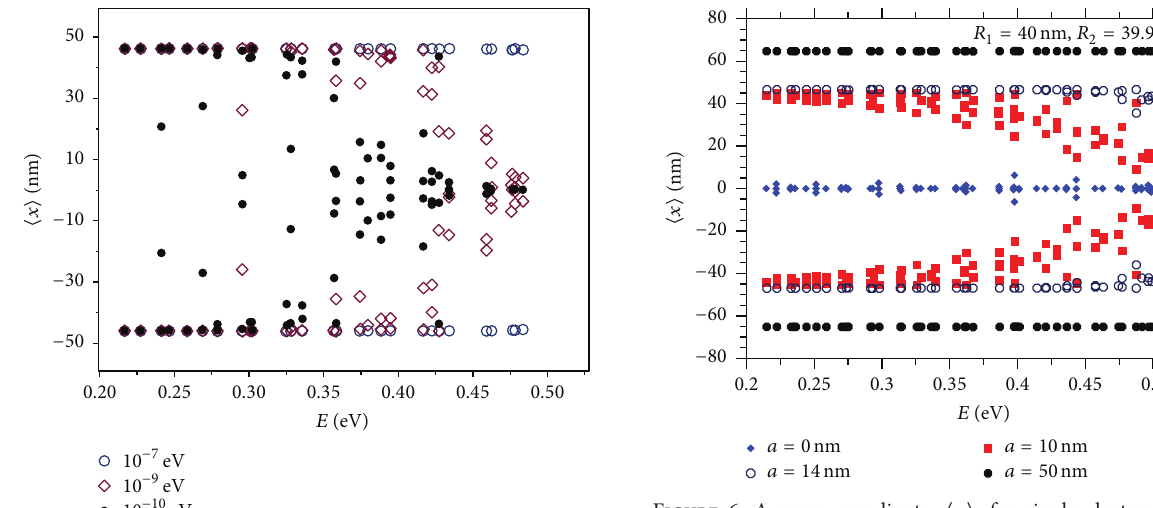
Figure 6: Average coordinate, ⟨𝑥⟩ , for single electron spectrum in the case of asymmetric DQW versus interdot distance 𝑎 . The asymmetry parameter is maintained constant and equal to 𝜉 = /𝑅 = 39.999/40 0 .99975 ( 𝜉 = 𝑅 2 1